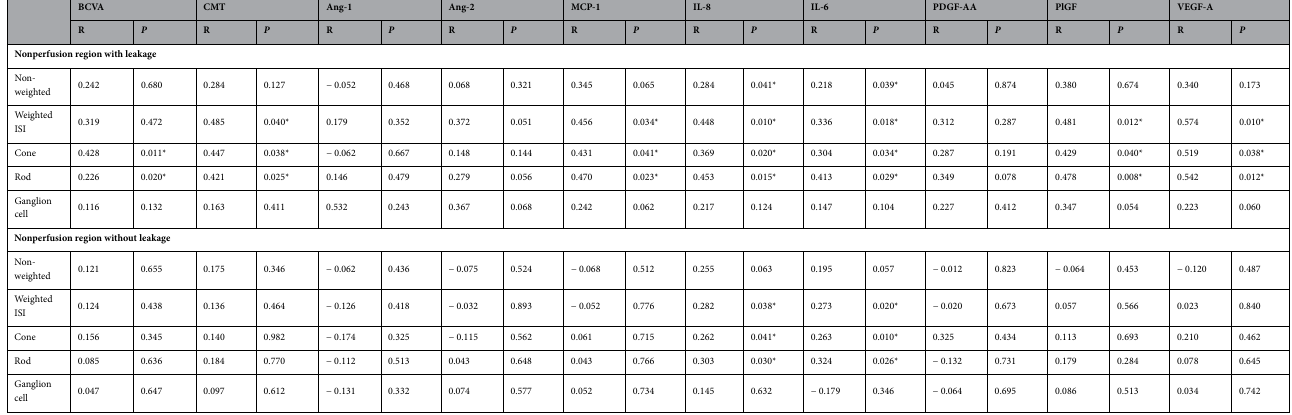
Table 2. Correlations of weighted and non-weighted ISI with visual acuity, central macular thickness, and levels of cytokines. P-values were calculated using Spearman correlation. BCVA best-corrected visual acuity, CMT central macular thickness, ISI ischemic index, R Spearman correlation coefficient. *P < 0.05.